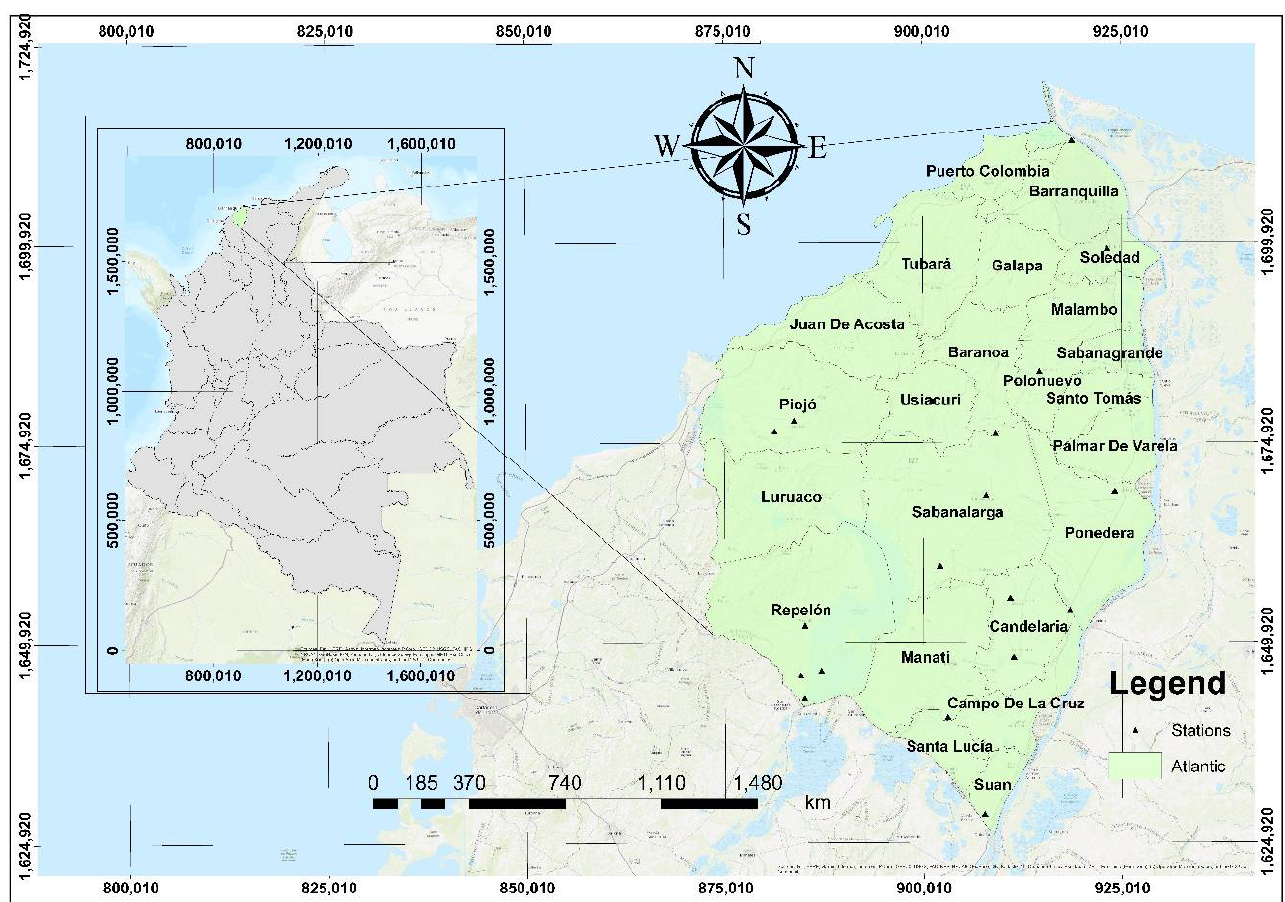
Figure 1. Political-administrative boundaries of the Atlántico region.